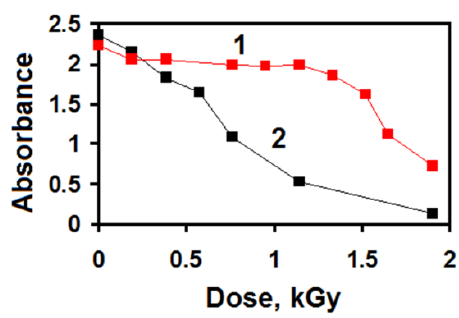
Figure 9. The dose- dependences of the optical density at λ = 226 of the irradiated VT – Au(III) (the (VT)/(Au(III)) ratio is 80/1) with (1) and without (2) ethanol (diluted by a factor of